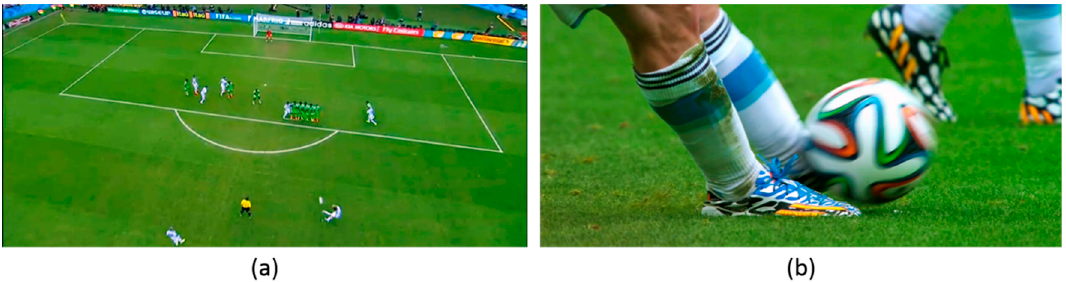
Figure 4. A Lionel Messi free kick during the 2014 World Cup; ( a ) the top view; ( b ) the pitch-level